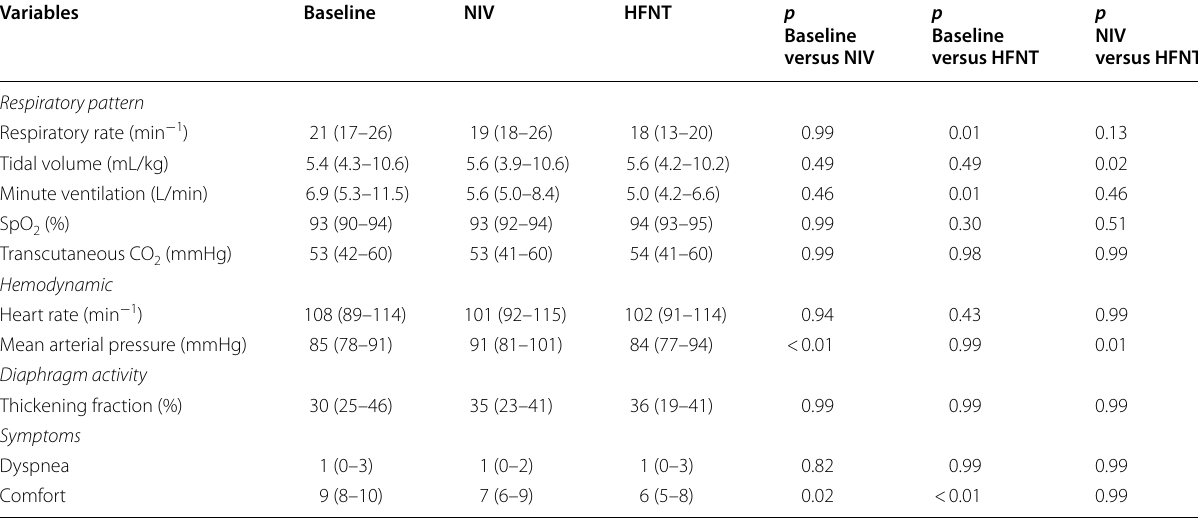
Continuous variables are expressed as median (interquartile range). Devices are compared head to head, and each device is compared to baseline conditions using the Wilcoxon signed-ranks test. HFNT high-flow nasal therapy, NIV noninvasive ventilation, n